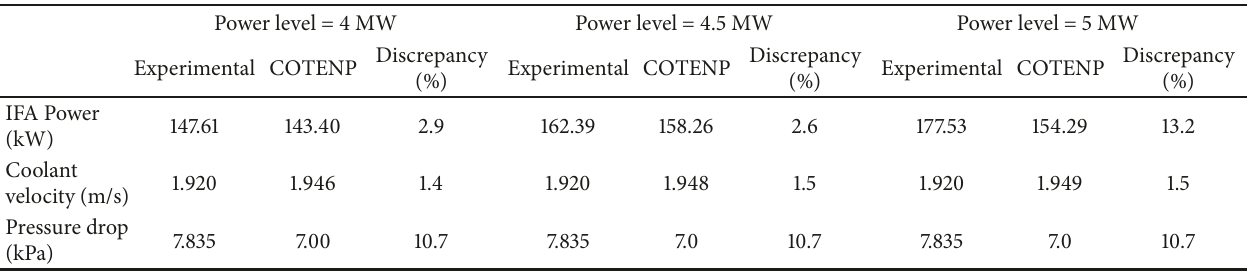
Table 3: IFA power, coolant velocity, and IFA pressure drop at different power levels of the IEA-R1 reactor ∗ . The IFA is located at the (6,8)